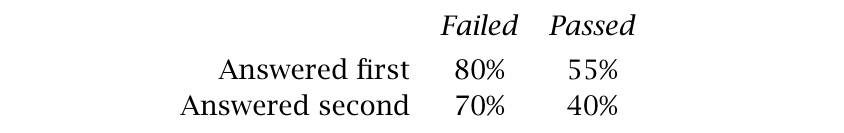
Percentages of positive answers by question and order for ques- tions (i) and